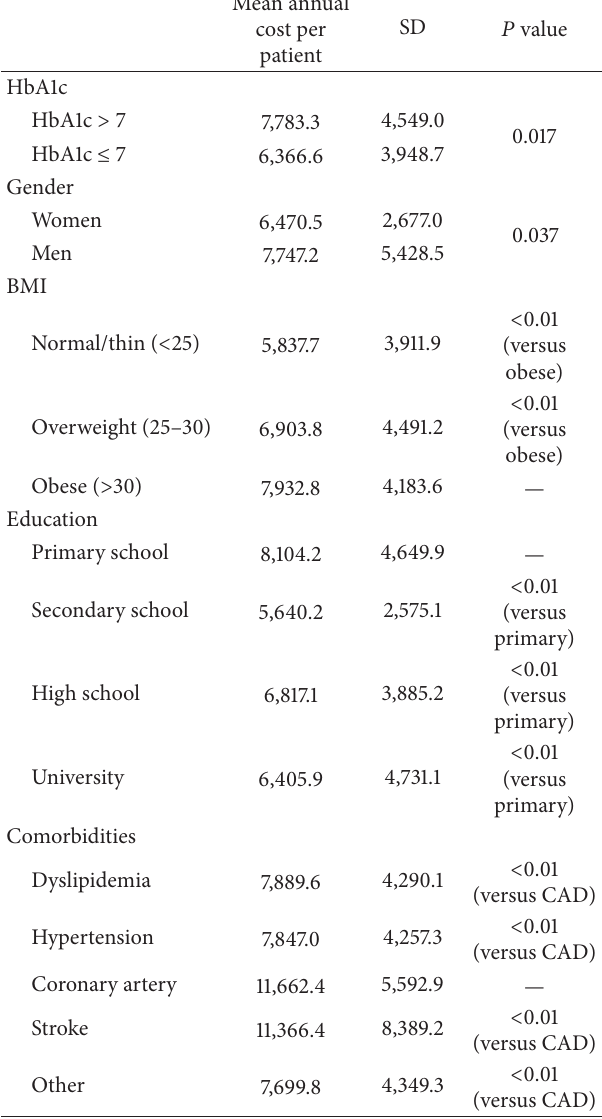
Table 5: Average annual costs by patient